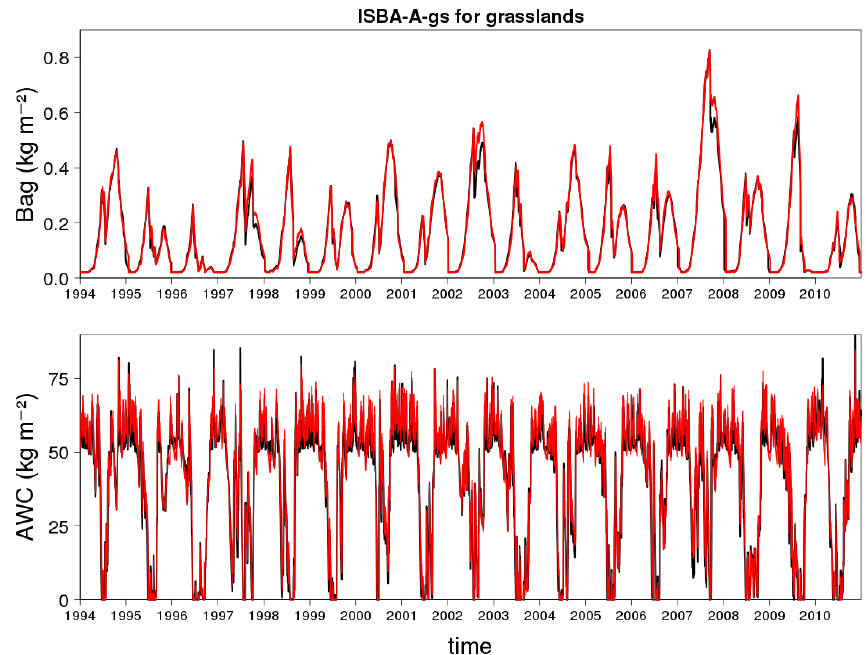
Figure 8. As in Fig. 7, except for grasslands ( g m = 0.5mms − 1 , MaxAWC = 50mm).